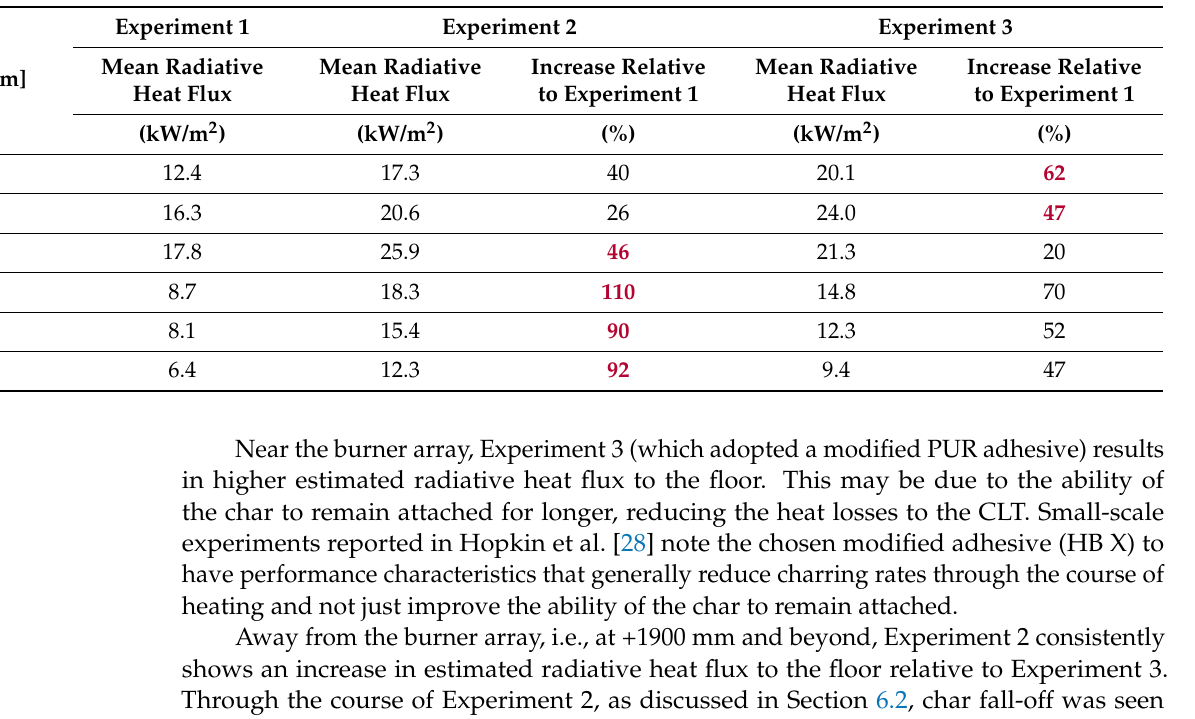
Table 2. Mean radiative heat flux to floor by offset from burner array and percentage increase relative to Experiment 1 (burner array HRR = 1250 kW). Red values indicate largest increase relative to Experiment 1 for the exposed CLT